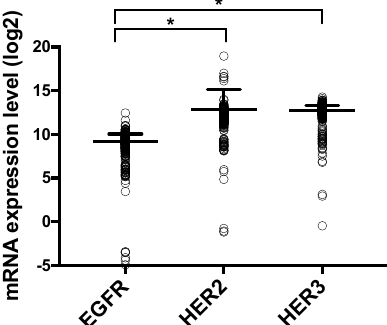
Figure 3. mRNA expression level of HER receptors in CRC patients, available from The Cancer Genome Atlas (TCGA). The graph shows the mRNA expression (mean and standard deviation) of EGFR, HER2, and HER3 from 382 CRC patients (individual dots). This dataset (TCGA Provisional, RNASeqV2) was downloaded from cBioportal. * p -value ≤